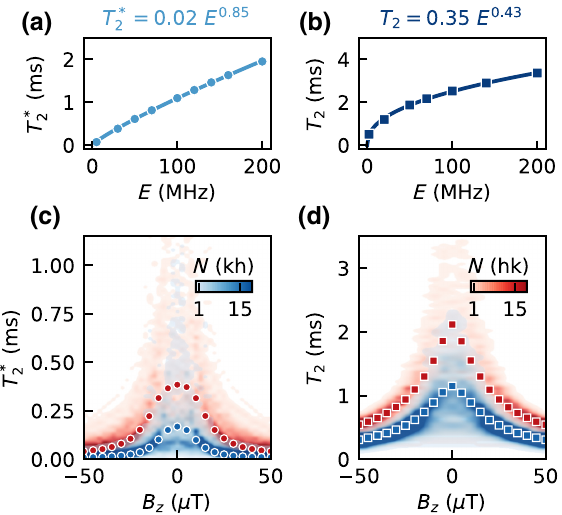
FIG. 6. Dependence of the coherence time on the transverse (a) and T 2 (b) zero-field splitting. (a),(b) Coherence times T ∗ 2 of the kh -V C V Si divacancy with different hypothetical values of transverse ZFS E . (c),(d) The heat map of the single defect T ∗ 2 ( T 2 ) for 120 different nuclear spin configurations of both the hk - V C V Si (red) and kh -V C V Si (blue) divacancies as a function of the magnetic field. The color corresponds to the number of config- ( T 2 ) at the given magnetic field. The urations with a given T ∗ 2 circles (squares) indicate the ensemble averaged coherence